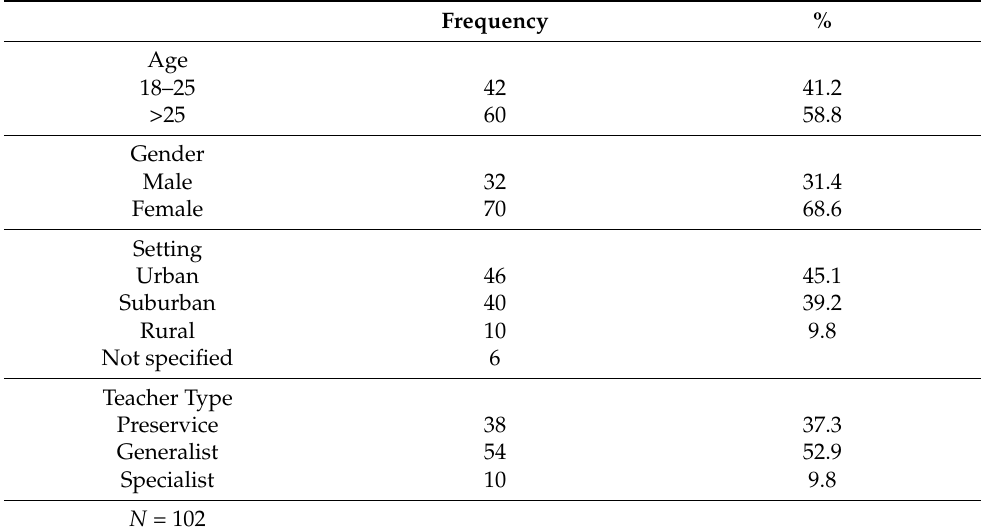
Table 1. Participant